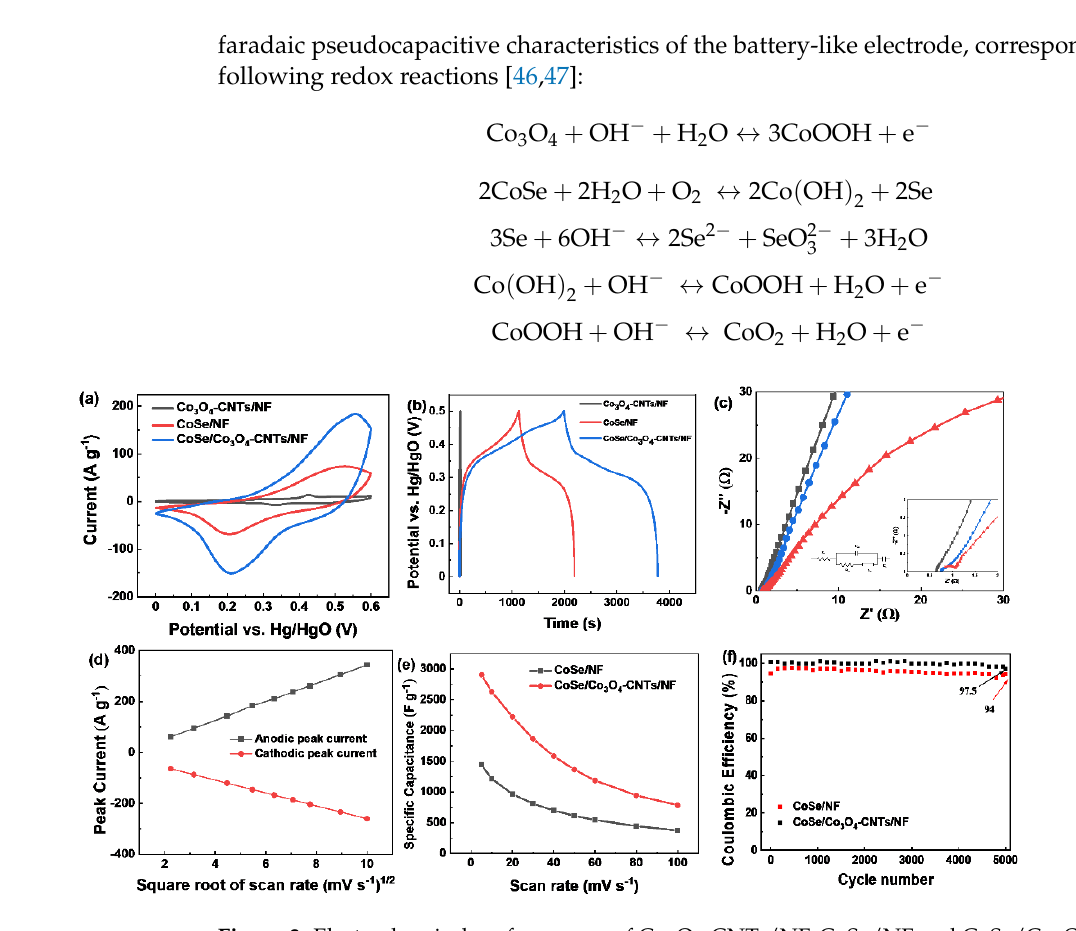
Figure 3. Electrochemical performances of Co 3 O 4 -CNTs/NF, CoSe/NF and CoSe/Co 3 O 4 -CNTs/NF: ( a ) CV curves scanned at a scan rate of 30 mV s − 1 ; ( b ) GCD curves at a current of 1 A g − 1 , ( c ) Nyquist plots; ( d ) fitting lines of peak current density for the square root of scan rates of CoSe/Co 3 O 4 - CNTs/NF; ( e ) specific capacitance of CoSe/NF and CoSe/Co 3 O 4 -CNTs/NF electrodes; ( f ) cycling stability for 5000 cycles at 10 A g − 1